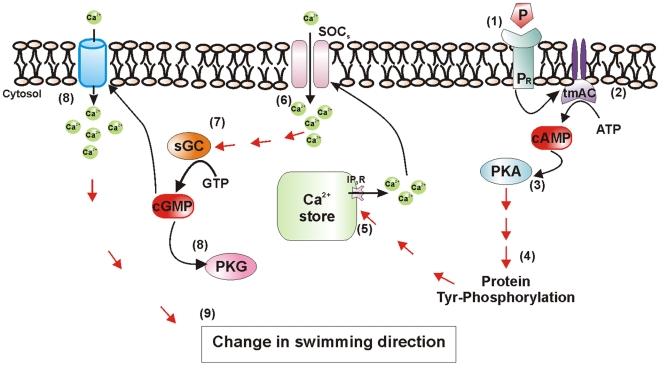
Molecular mechanisms involved in the sperm chemotaxis mediated by progesterone.1, P-PR interaction; 2, tmAC activation and cAMP synthesis; 3, PKA activation; 4, protein phosphorylation; 5, stored Ca2+ released through IP3R channel; 6, first Ca2+ influx through SOC channel; 7, activation of sGC with an intracellular cGMP increase; 8, PKG activation and a second Ca2+ influx probably through other calcium channels; 9, change in sperm swimming direction. Data from this study are shown with black arrows while unknown connecting steps are marked with red arrows. See text for further explanation of the model.